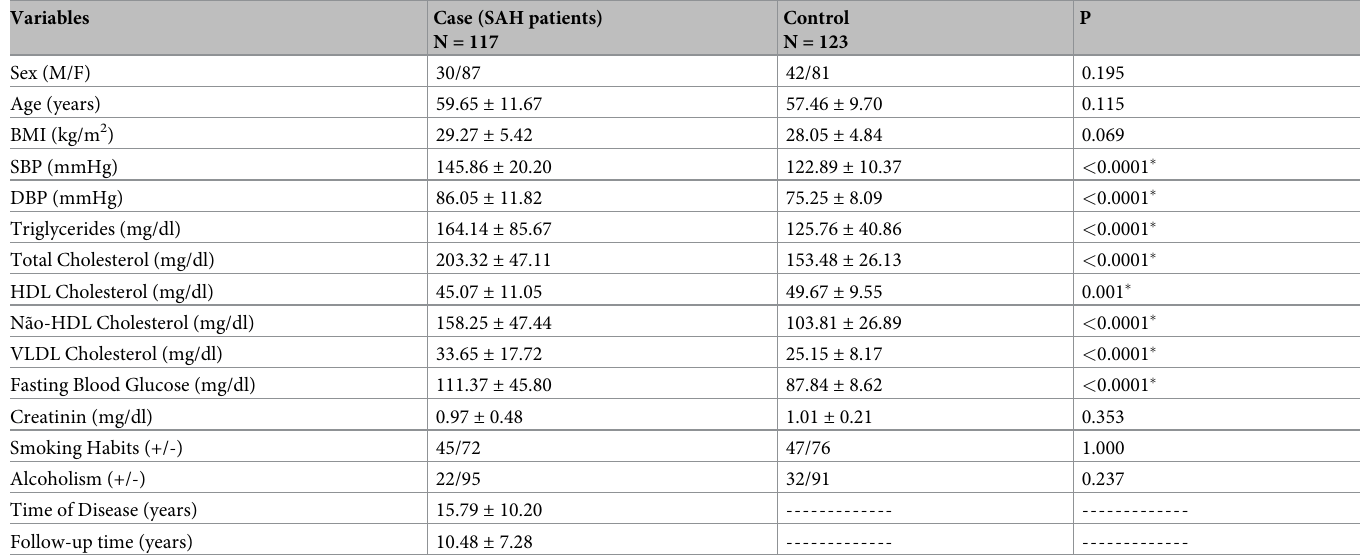
Table 1. Characteristics of the study population.